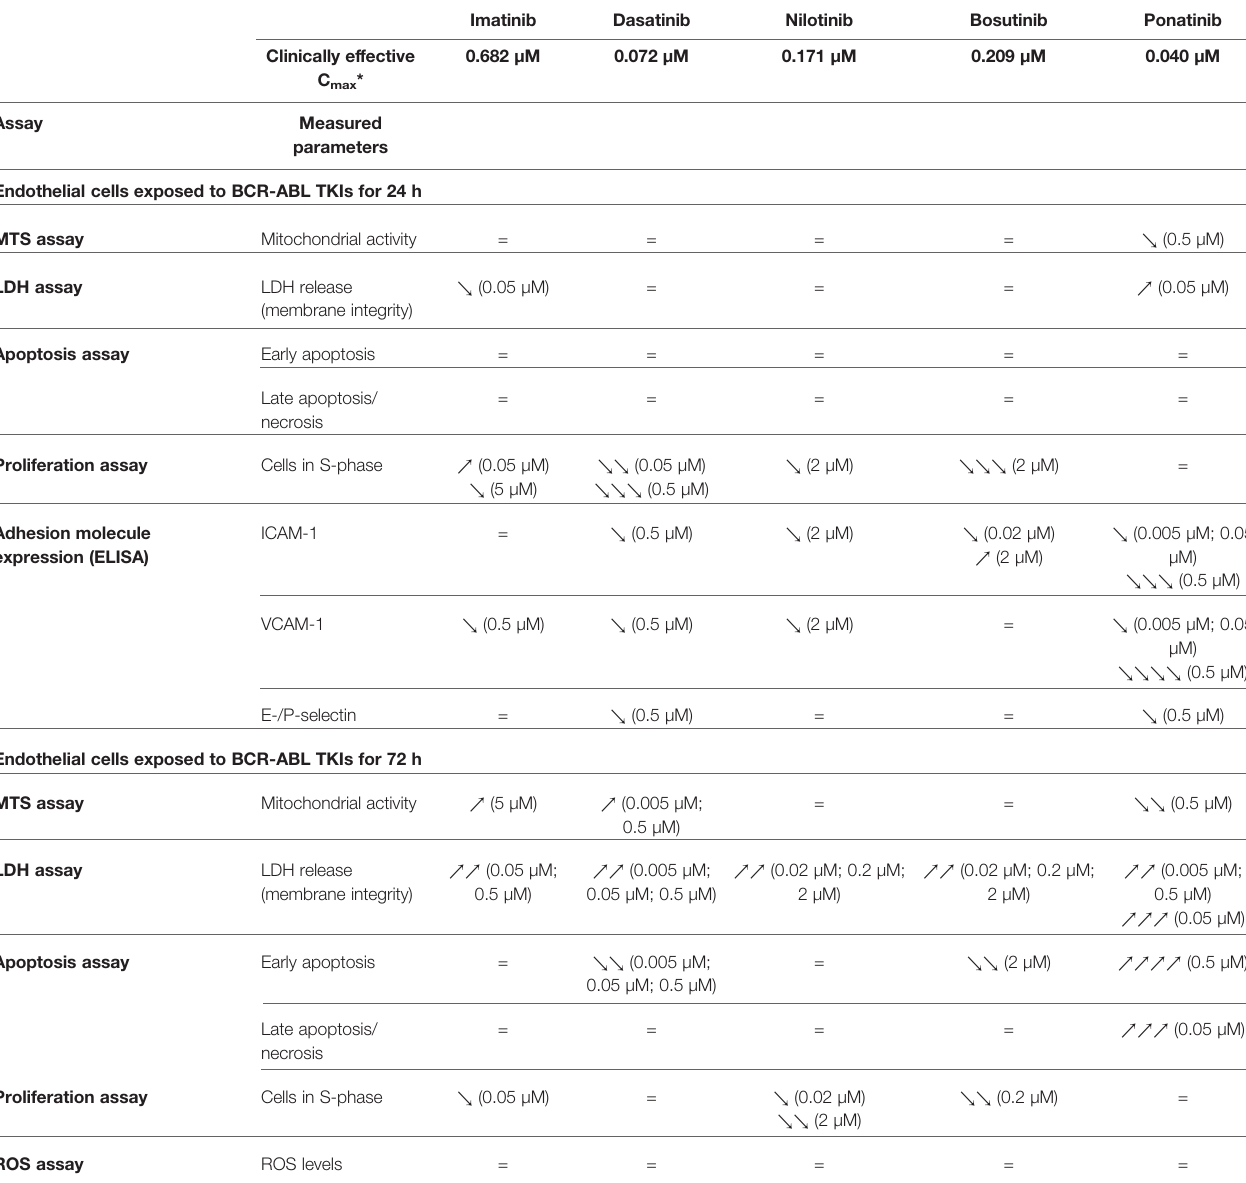
TABLE 1 | Summary of the fi ndings of the impact of BCR-ABL TKIs on endothelial cells in vitro